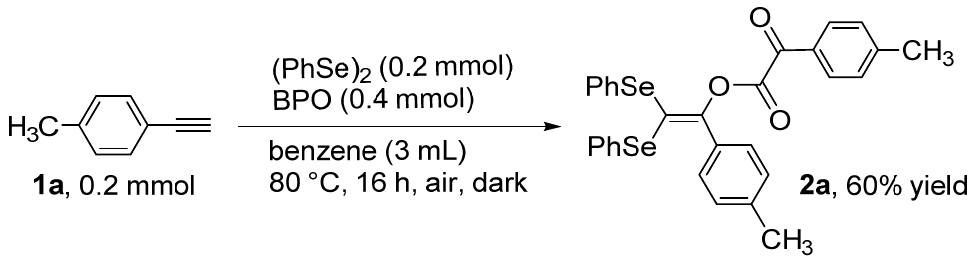
Figure 1. Crystal structure of 2a with numbered atoms. Ellipsoids are shown at the 50% probability level. Selected interatomic distances (Å) and angles (deg): Se1 − C1, 1.9178(17); Se1 − C10, 1.916(2); Se2 − C1, 1.9021(19); Se2 − C16, 1.9188(19); O1 − C2, 1.420(2); O1 − C22, 1.360(2); O2 − C22, 1.195(2);